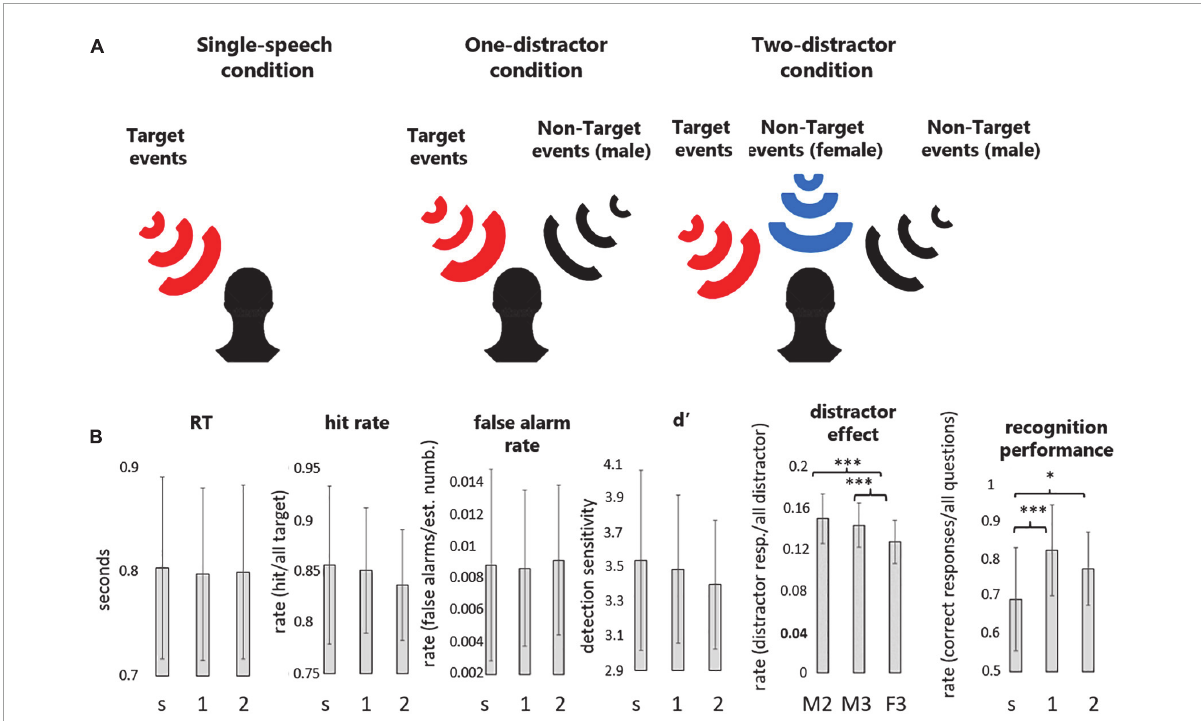
FIGURE1 (A) Schematic illustration of the three experimental conditions. Participants were instructed to track the contents of the speech presented from the target location while also performing a numeral detection task on the same stream. In separate experimental conditions, participants were presented with (1) one speech stream (single-speech condition), (2) two speech streams (one-distractor condition), or (3) three speech streams (two-distractor condition). The target stream was always presented from the left of the listener (red loudspeaker). The black and blue wave symbols indicate the distractor male and distractor female streams, respectively. (B) Group average ( N = 23) performance (mean and standard deviation) in the numeral detection task indexed by RT, hit rate, false alarm rate, d (cid:48) , and the distractor effect, as well as recognition performance in the content-tracking task, separately for the three experimental conditions (s: single-speech condition, 1: one-distractor condition, 2: two-distractor condition). Note that because no distractor was present in the single-stream condition, the distractor effect was only calculated for the male speaker in the one-distractor (M2), the male speaker in the two-distractor (M3), and the female speaker in the two-distractor (F3) condition. ∗ p < 0.05, ∗∗∗ p < 0.001, and + 0.05 < p <